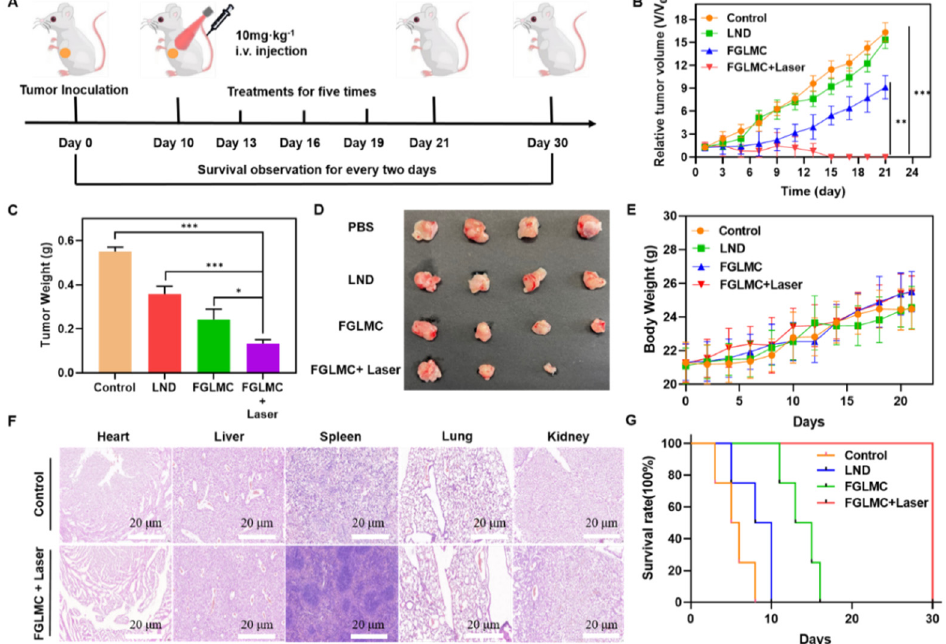
Figure 6. In vivo therapeutic effects of LND, FGLMC without or with laser. ( A ) Schematic illustration of the administration route for in vivo therapy. ( B ) Relative tumor volume, ( C ) tumor weight, ( D ) tumor image of MCF − 7 tumors from different groups. ( E ) Bodyweight of MCF-7 tumor-bearing mice administrated with different formulations. ( F ) H&E − staining images of major organs (scale bar represents 100 μ m). ( G ) The survival rate of MCF − 7 tumor-bearing mice received different treatments. Error bars indicate SD ( n = 4). (* p < 0.05, ** p < 0.01, *** p < 0.005).